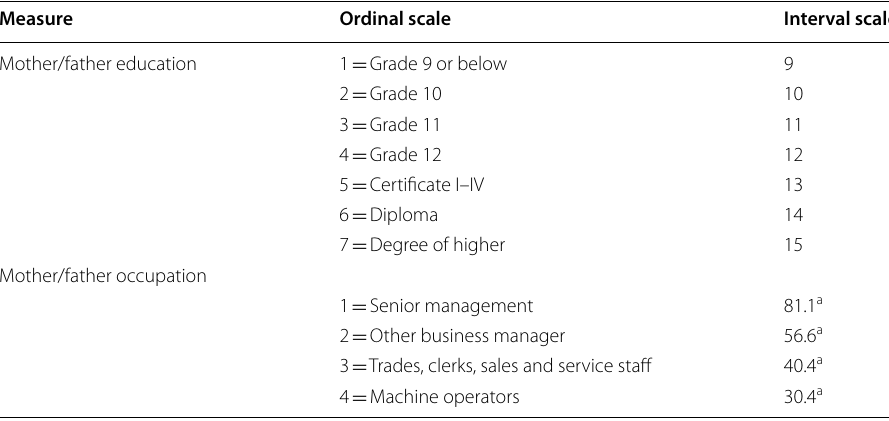
a Average AUSEI06 score for each category